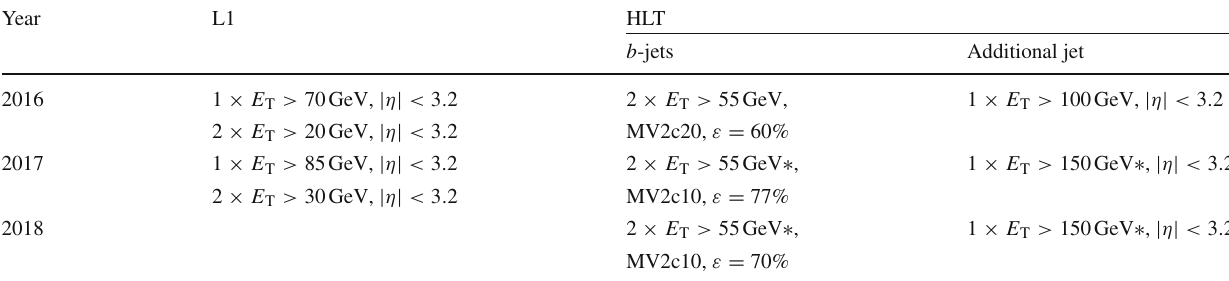
Table 4 Details, by year, of the lowest-threshold unprescaled triggers requiring a high- p T jet plus two b -jets signature, such as might arise from the process where a particle decaying into two b -jets is accompa- nied by a jet from initial- or final-state radiation. No b -tagging require- ments are applied to this ’additional jet’ in the event. The minimum